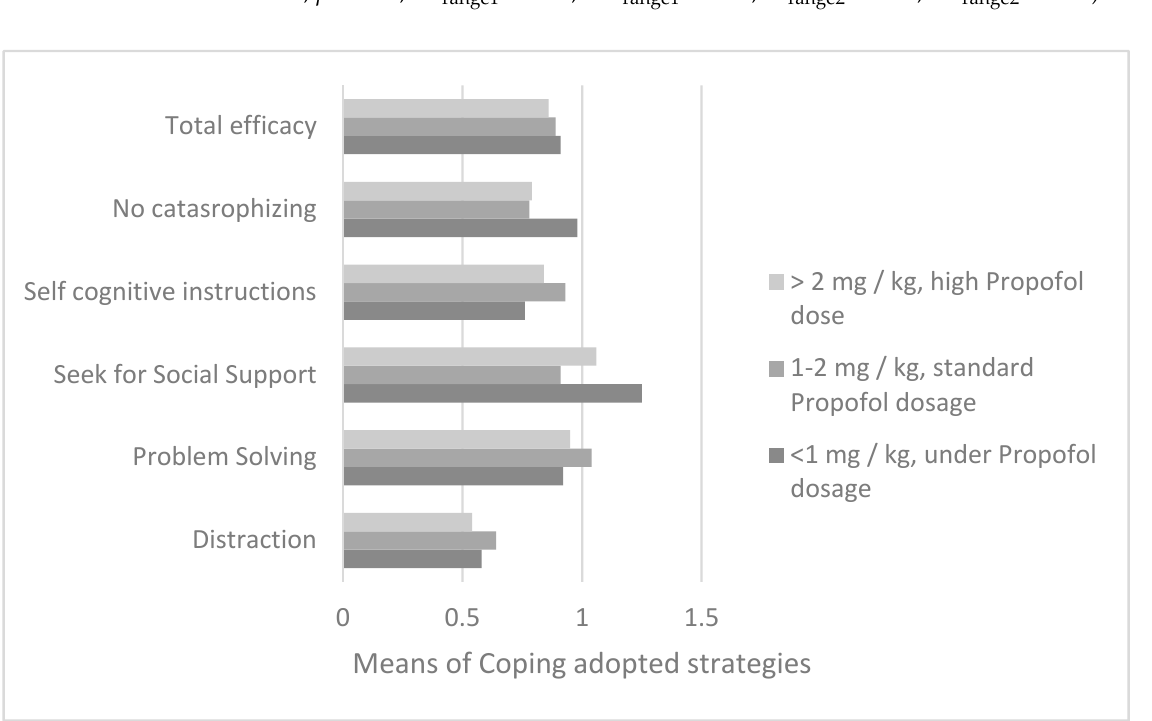
Figure 5. Comparison between the averages of the 5 coping strategies adopted along the average dosage of propofol taken in the sedation induction phase for the bone marrow aspirate of day +33.